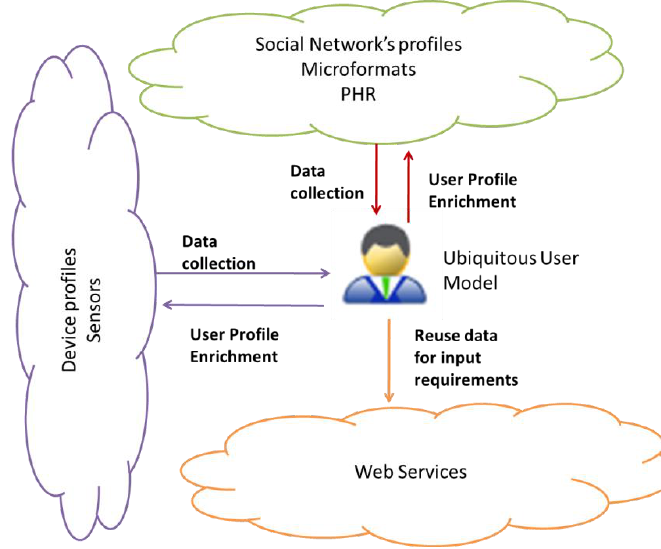
Figure 2. Exchange patterns between profile suppliers and